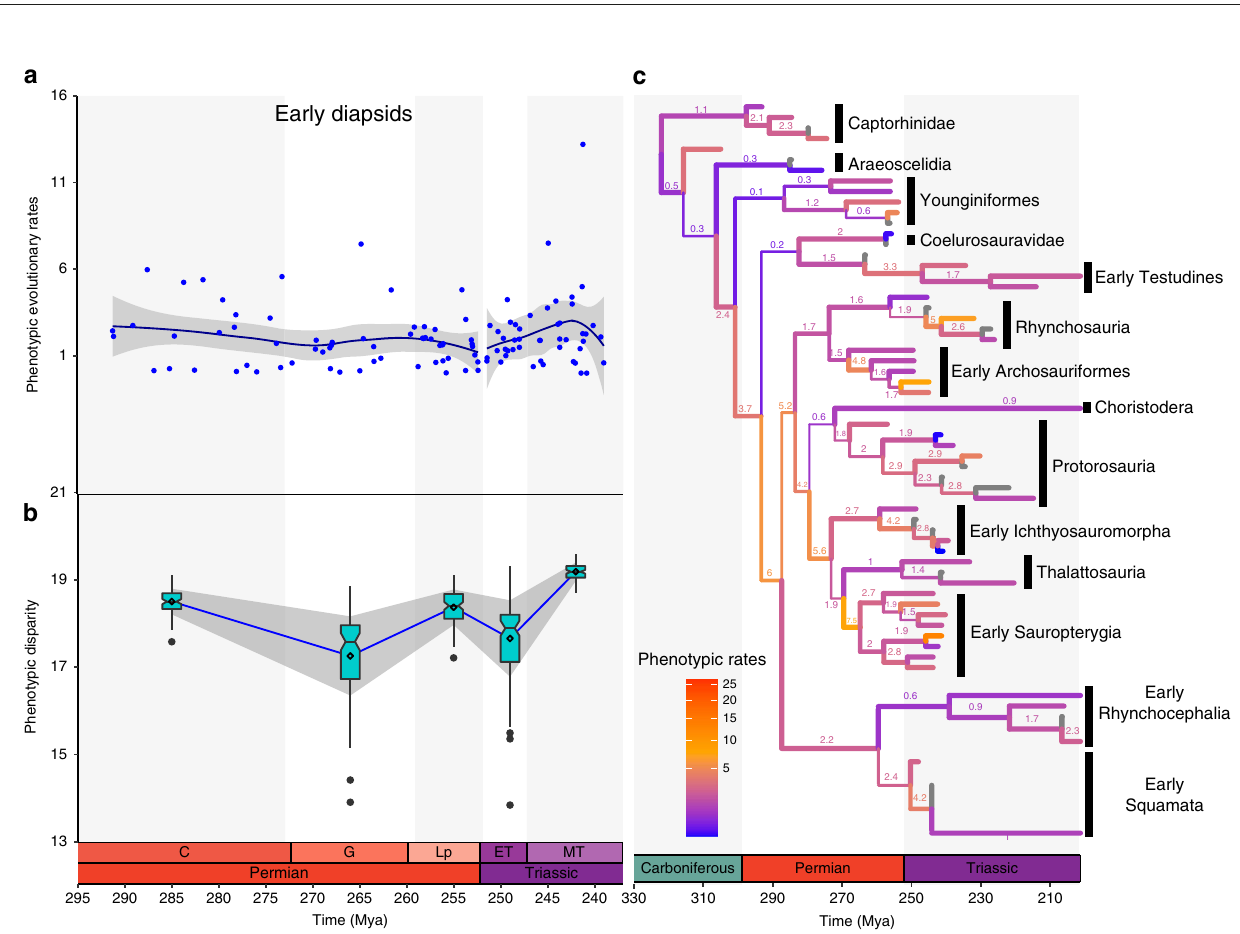
Fig. 1 Distribution of phenotypic and molecular relative evolutionary rates in different reptile groups. Rates are relative to the mean posterior estimate of base of the clock rate value ( = 0.00345 substitutions per character per myr). a distribution of phenotypic rates among early evolving diapsid lineages (median = 1.9; mean = 2.1). b distribution of phenotypic (median = 0.51; mean = 1.0) and molecular rates (median = 0.54; mean = 0.83) among lepidosaurs. c linear regression between phenotypic and molecular rates (log-transformed) among lepidosaurs (R-squared: 0.0001425; p -value: 0.8615; two-sided). n = 109 ( a ) and n = 211 ( b , c ) for molecular and phenotypic evolutionary rates pooled from all unique bipartitions from the posterior trees. Shaded grey area = 95% CI. Source data are provided as a Source Data fi le.